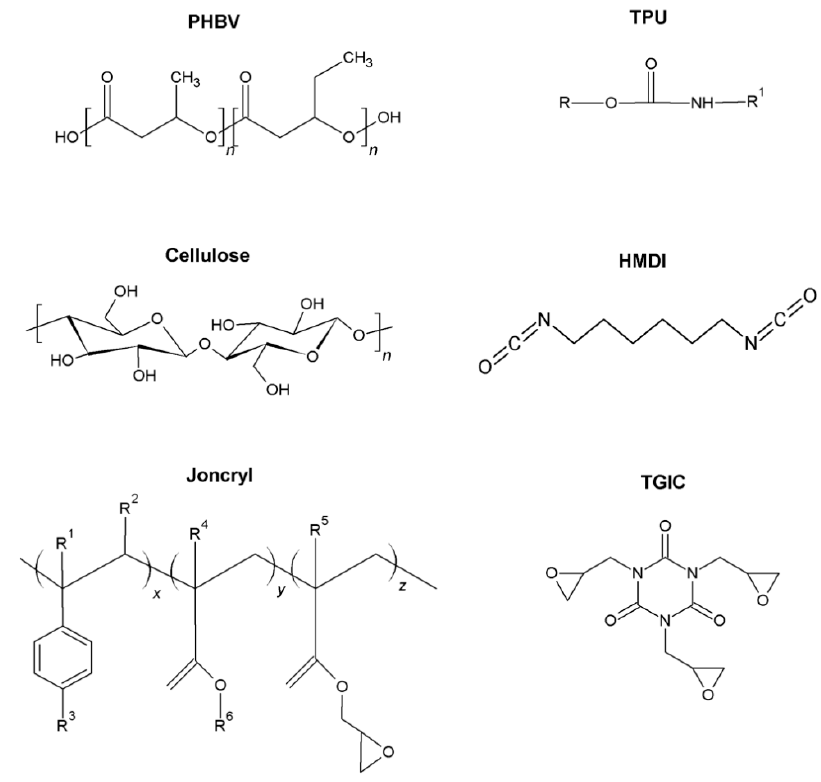
Figure 1. Chemical structures of materials used in this study.